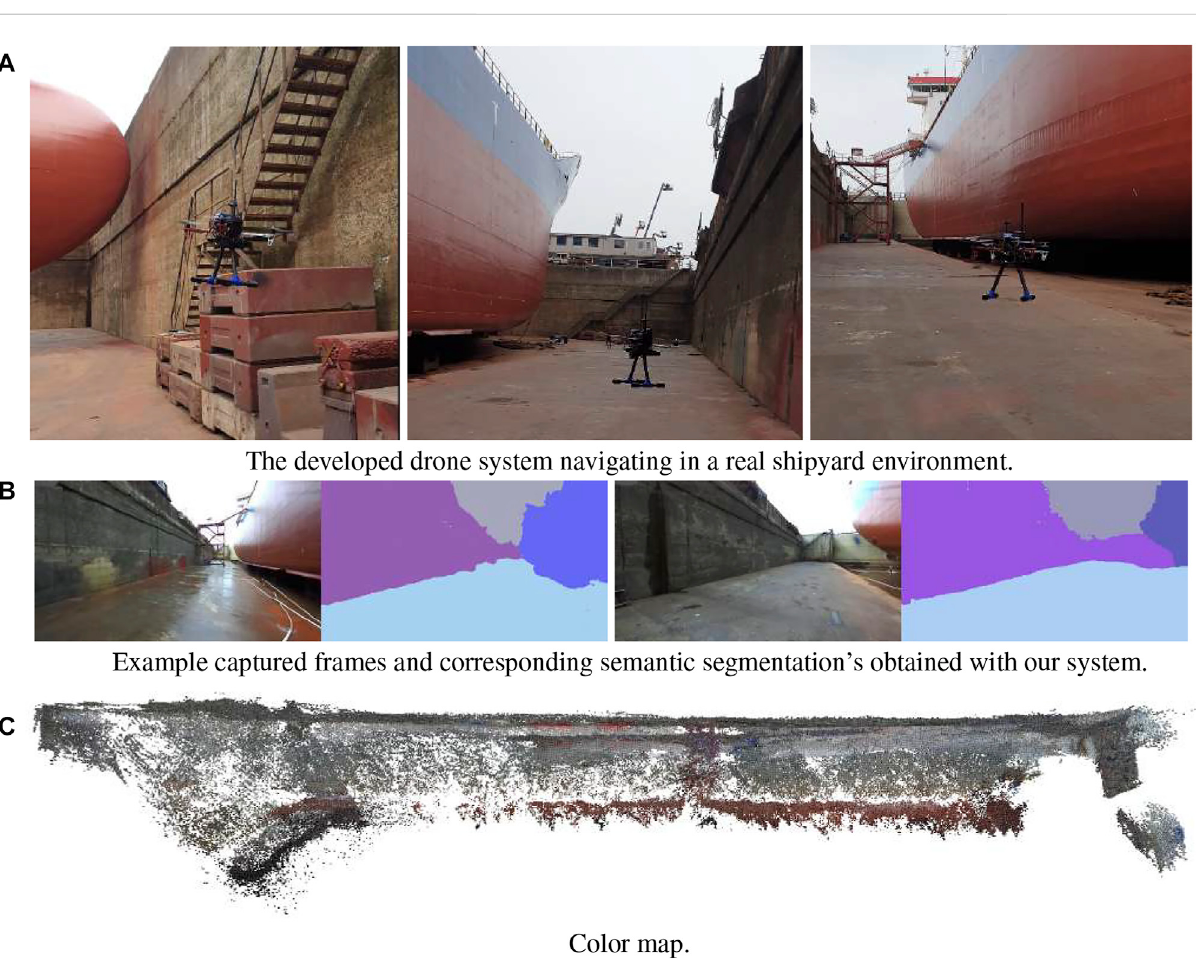
FIGURE 10 Mapping task performed with our fi nal system design. (A) The developed drone system navigating in a real shipyard environment, (B) Example captured frames and corresponding semantic segmentation ’ s obtained with our system, (C) Color map.